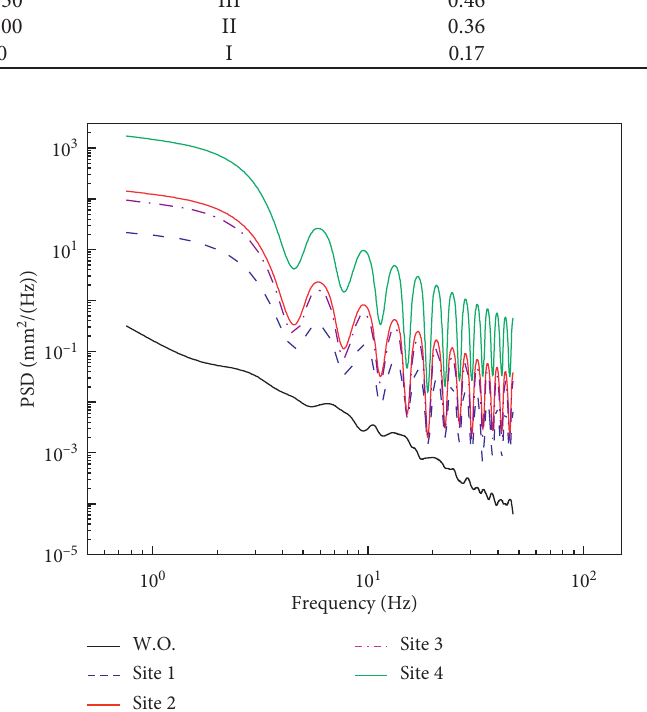
Figure 14: PSD comparisons of alignment irregularities under different soil sites.